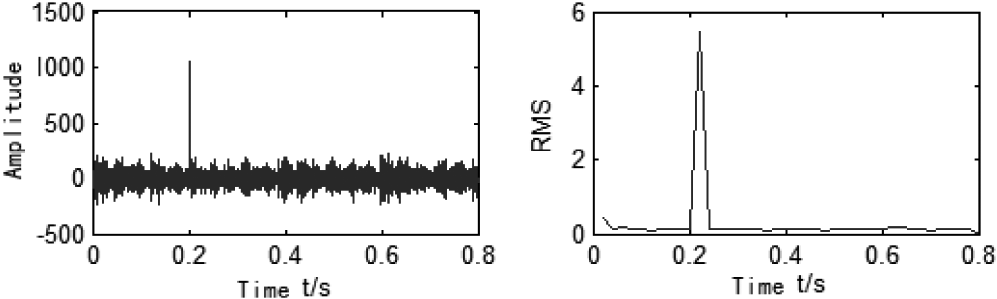
Fig. 4. Generated impulse.